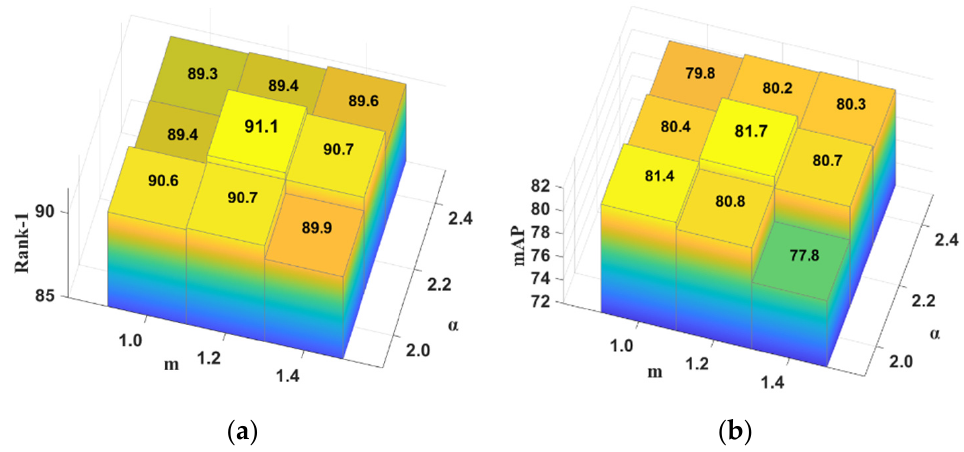
Figure 4. Optimization of AML baseline loss functions on Market-1501 datasets. ( a ) Results of different hyperparameters on Rank-1; ( b ) Results of different hyperparameters on MAP.